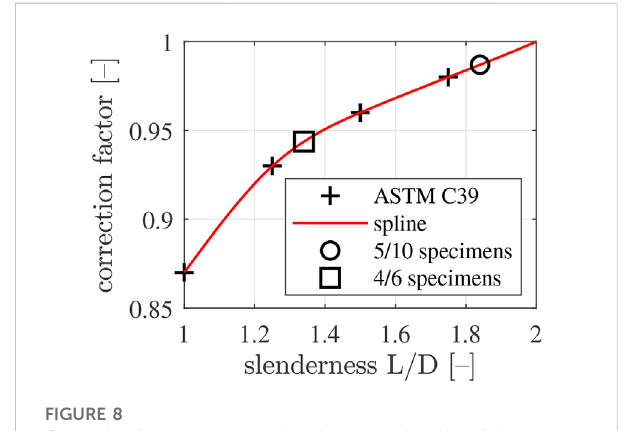
FIGURE 8 Correction factors compensating the overestimation of the genuineuniaxialcompressivestrengthofconcreteasafunctionofthe slenderness-ratio: “ + ” symbols mark values taken from ASTM C39 standard American Society for Testing and Materials (2021), thered graph is aspline running through thedata points ofASTM C39, the “ □ ” symbol marks the correction factor referring to the slenderness-ratio of the 4/6 specimens, and the “ ◦ ” symbol marks the correction factor referring to the slenderness-ratio of the 5/10